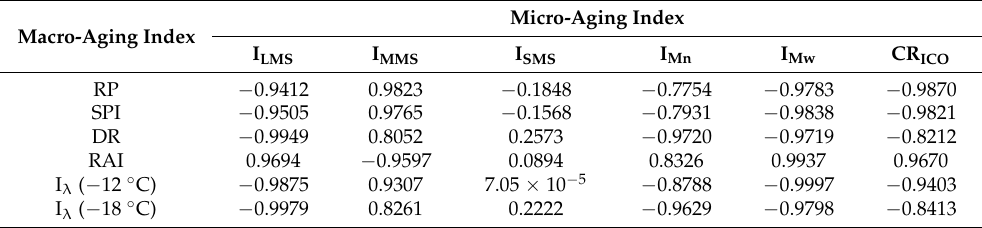
Table 5. Pearson correlation